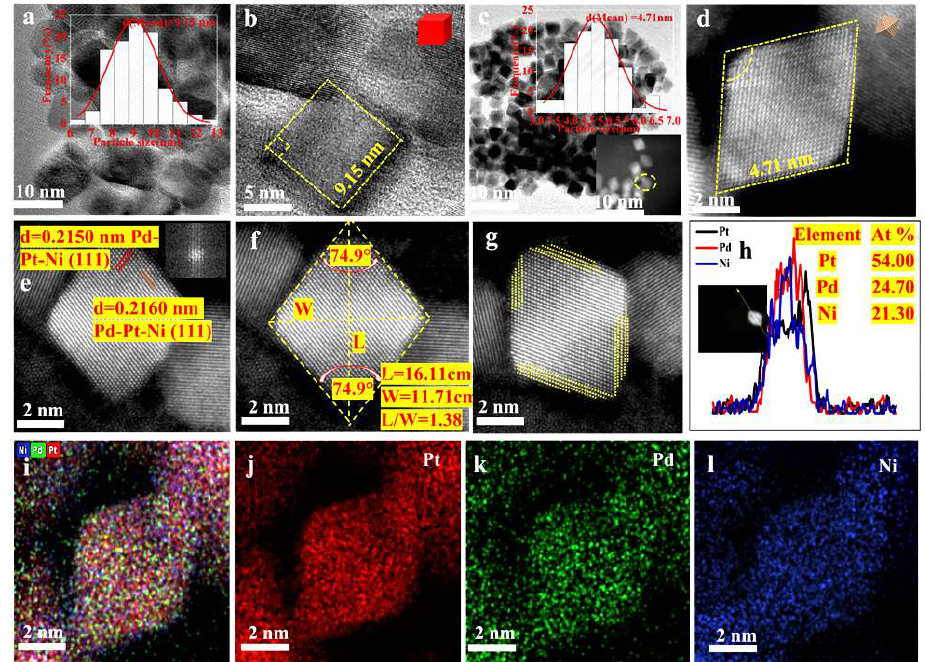
Figure 1. ( a – k ) TEM images of Pd nanocube (Pd NCs) seed and ultra-small octahedra (Pd-Pt-Ni Octa1): ( a ) TEM image of Pd NC seed with particle size distribution; ( b ) TEM image of a single Pd NC; ( c ) TEM image of Pd-Pt-Ni Octa1 with particle size distribution; ( d ) TEM image of a single Pd- Pt-Ni Octa1; ( e ) high-magnification TEM image of Pd-Pt-Ni Octa1 and calibration of atomic spacing